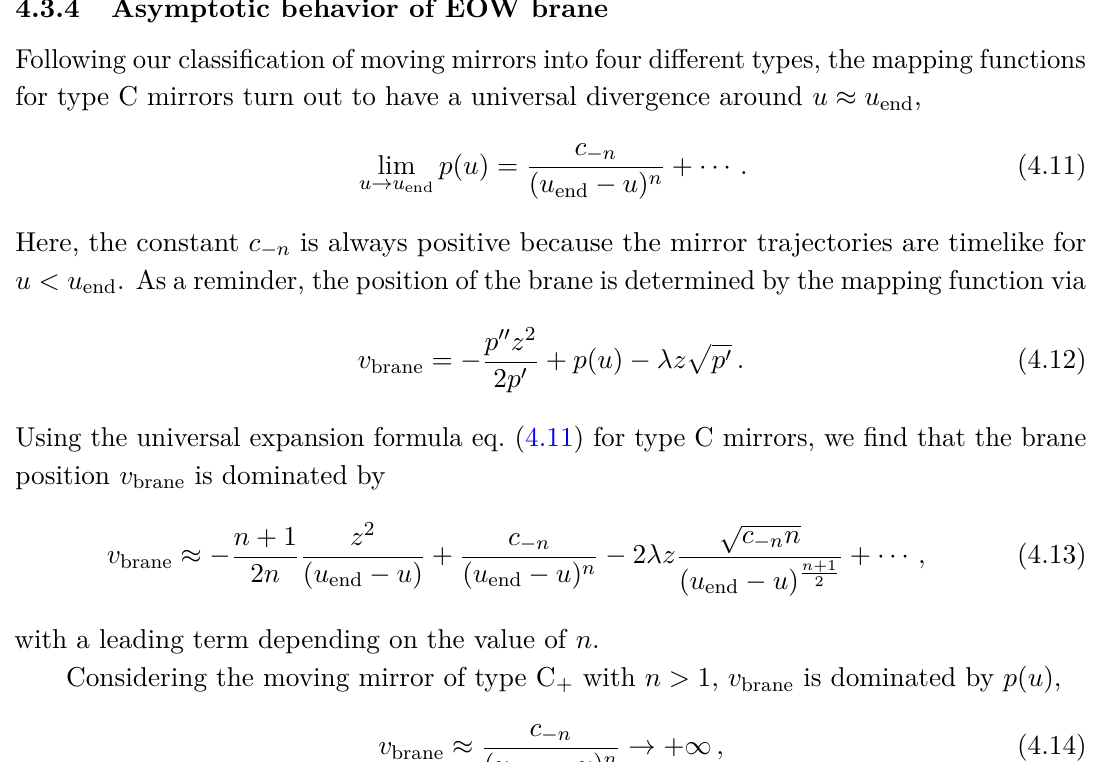
= 0 , and n = 1 for both end